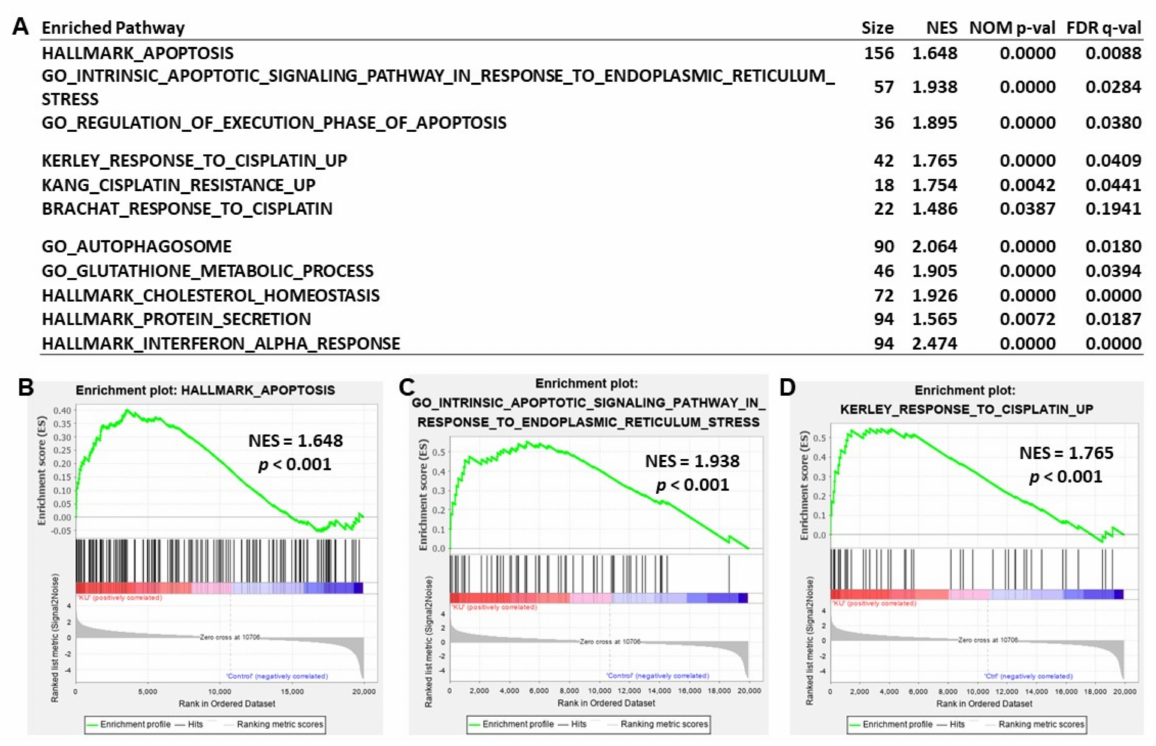
Figure 5. The ATM kinase inhibitor KU55933 induces apoptosis and other cellular pathways in HEp-2 cells. ( A ) Gene set enrichment analysis showed some representative pathways induced by KU55933. Additional KU55933- enriched pathways can be found in Supplementary Table S2. ( B – D ) Enrichment plots show the KU55933-enriched genes (left side) in the gene sets of HARLLMARK_APOPTOSIS ( B ), GO_APOPTOTIC_SIGNALING_PATHWAY_IN_ RESPONSE_TO_ENDOPLASMIC_RETICULUM STRESS ( C ), and KERLEY_RESPONSE_TO_ CISPLATIN_UP ( D ). The sig- nificant core enriched genes can be found in Supplementary Table S3. Size, gene number in the pathways. NES, normalized enrichment score. NOM, nominal. FDR, false discovery